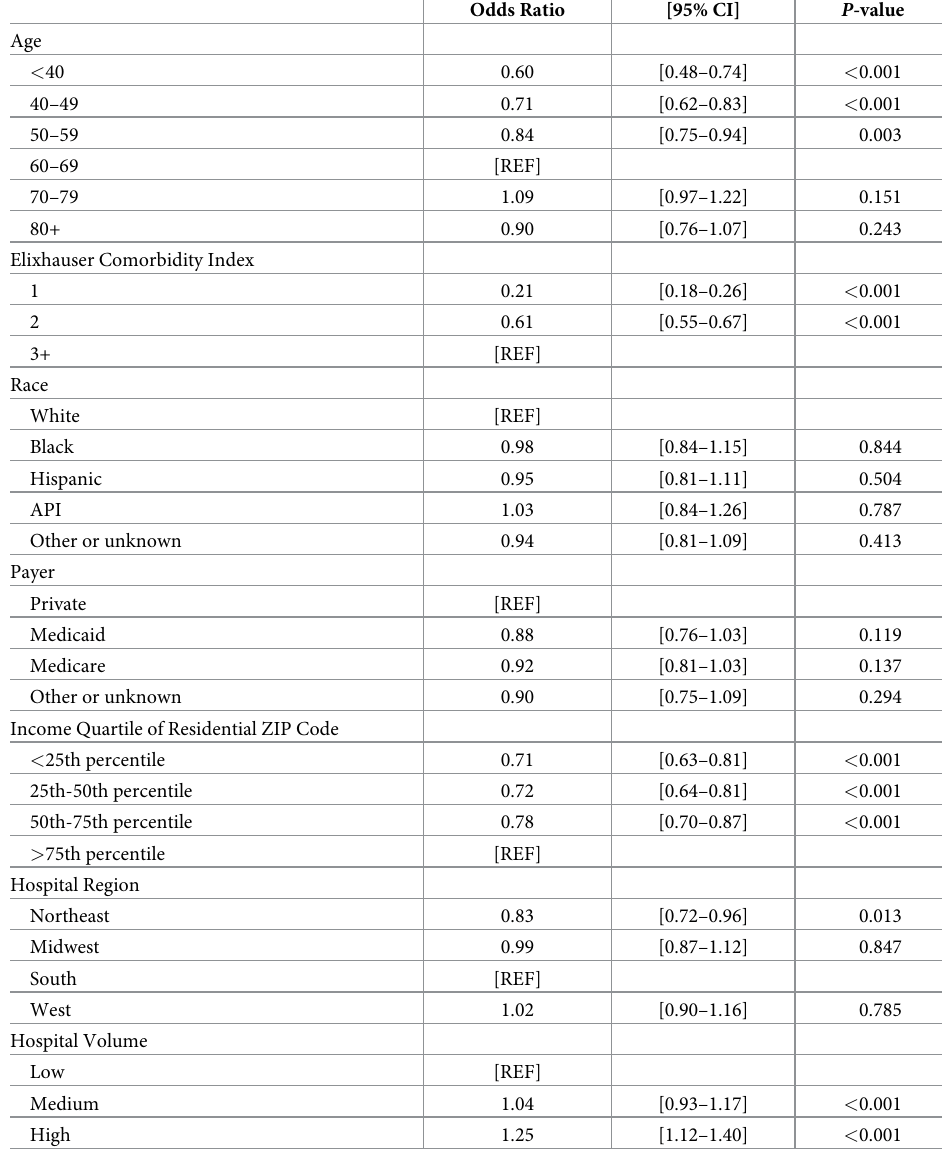
Table 2. Independent predictors of receiving